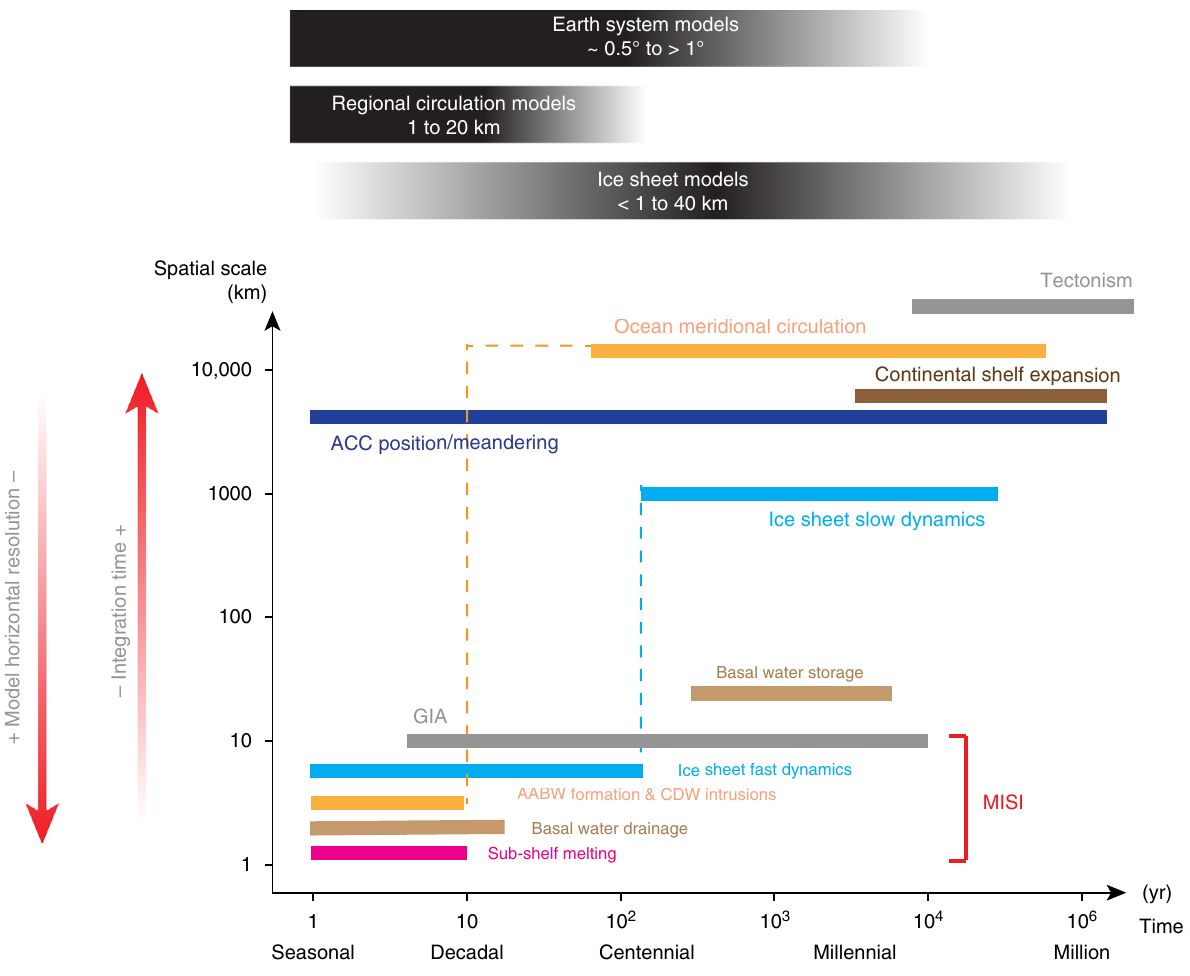
Fig. 7 Spatio-temporal scales of the processes discussed in the present review. Short-term processes occurring at local to regional scales are the ones potentially triggering MISI. Heat transport from open ocean to the continental shelf also depends on the long-term meridional overturning circulation (dashed orange line). Similarly, short-term ice sheet dynamics, and their response to local forcing, depend partly on its long-term evolution. The dif fi culty for the modeling community resides in capturing the long-term essence of those processes, occurring at continental to global scale and short-term response occurring at local to regional scales within the same simulation. A trade-off between numerical model horizontal resolution and integration time is so far still necessary. Note that vertical resolution of numerical models is not mentioned but is essential to capture the continental slope and shelf oceanic processes (heat, salt and nutrient transport). No atmospheric processes are reported here but they are implicitly contained in the AABW formation, CDW intrusions, ACC position and meandering (winds effect, polynya opening, etc.) and in ice-sheet short and fast dynamics (surface mass balance processes) as described in the previous sections. Note that glacio-isostatic adjustment (GIA) and sub-shelf melting are to be discussed in upcoming reviews by Smith et al. (in preparation) and Whitehouse et al. (in preparation). Tectonism refers to volcanism and crustal deformation of timescales that are beyond the